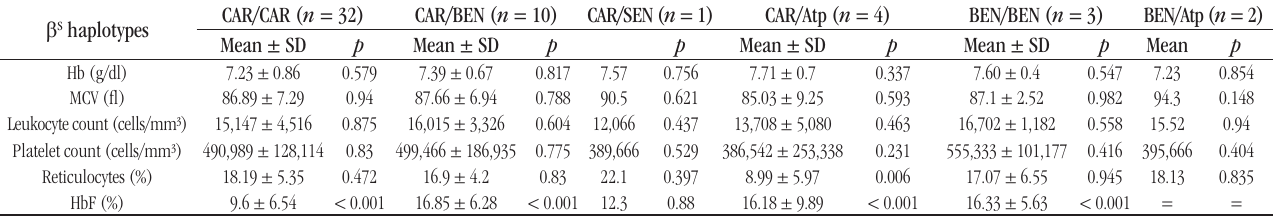
taBLE 1 − Laboratory parameters × β S -globin haplotypes according to genotypes ( n = 52)